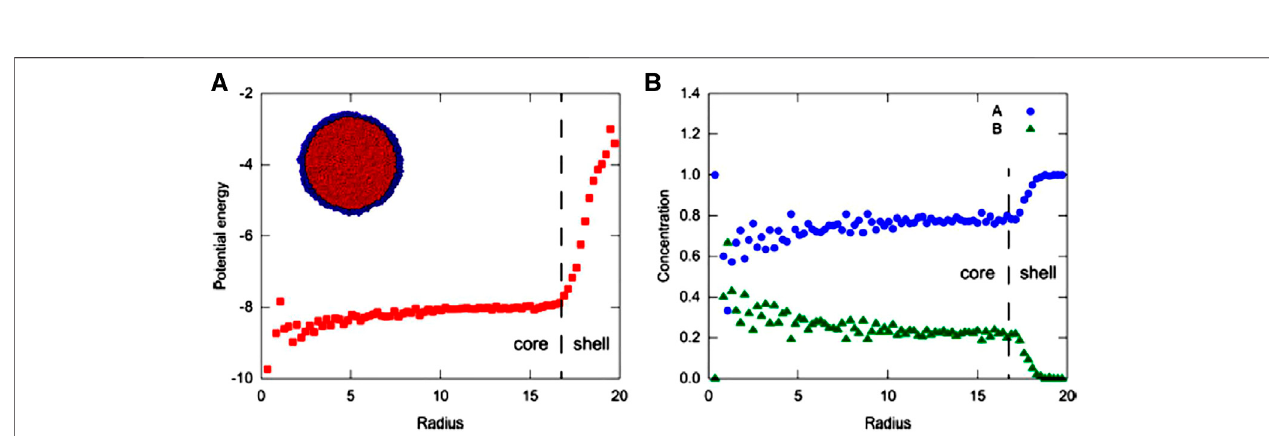
FIGURE 5 | (A) represents the radial pro fi les of the nanoglass as a function of potential energy. The inset of (A) shows the cross section of the nanoglass. The red atomssignifythecore,andtheblueatomsrepresenttheshell.In (B) ,thenanoglassoftheABcompositionispreparedbyvaporphasedepositionwherebluecirclesand green triangles are assigned to the concentration of A and B atoms, respectively. The image was adapted from the (Danilov et al., 2016).